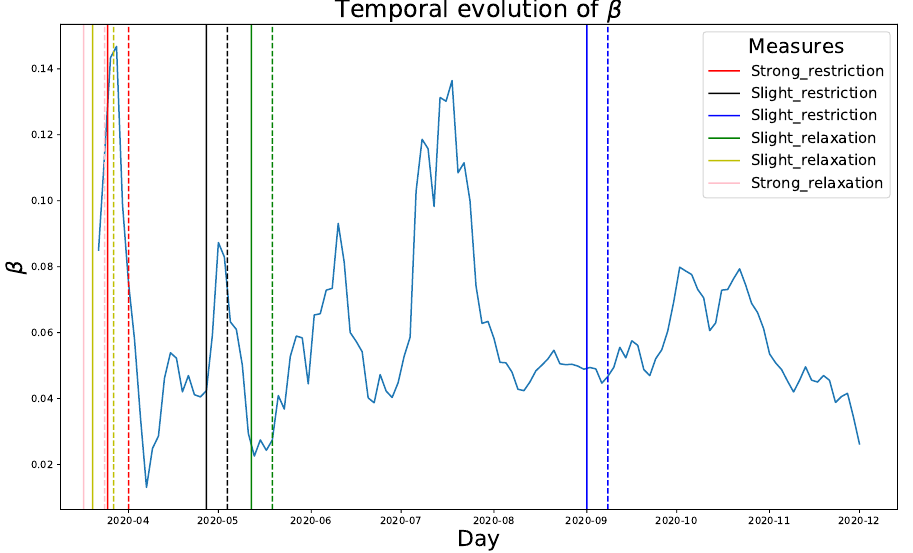
Figure 2. Representation of the variation of the β parameter without applying the expert system (blue curve). The horizontal coordinate represents time, while the vertical coordinate represents this coefficient. The higher the value is, the more contacts have infected individuals. The solid vertical lines represent the dates on which the government imposed a new measure and the dotted vertical lines are the approximate dates on which the consequences of these measures are expected to become visible. This time lag, which has been considered to be 10 days, is due to the existence of an incubation period of the disease, where no symptoms are present even though contagion has occurred, and an adaptation period until the measure is fully established.